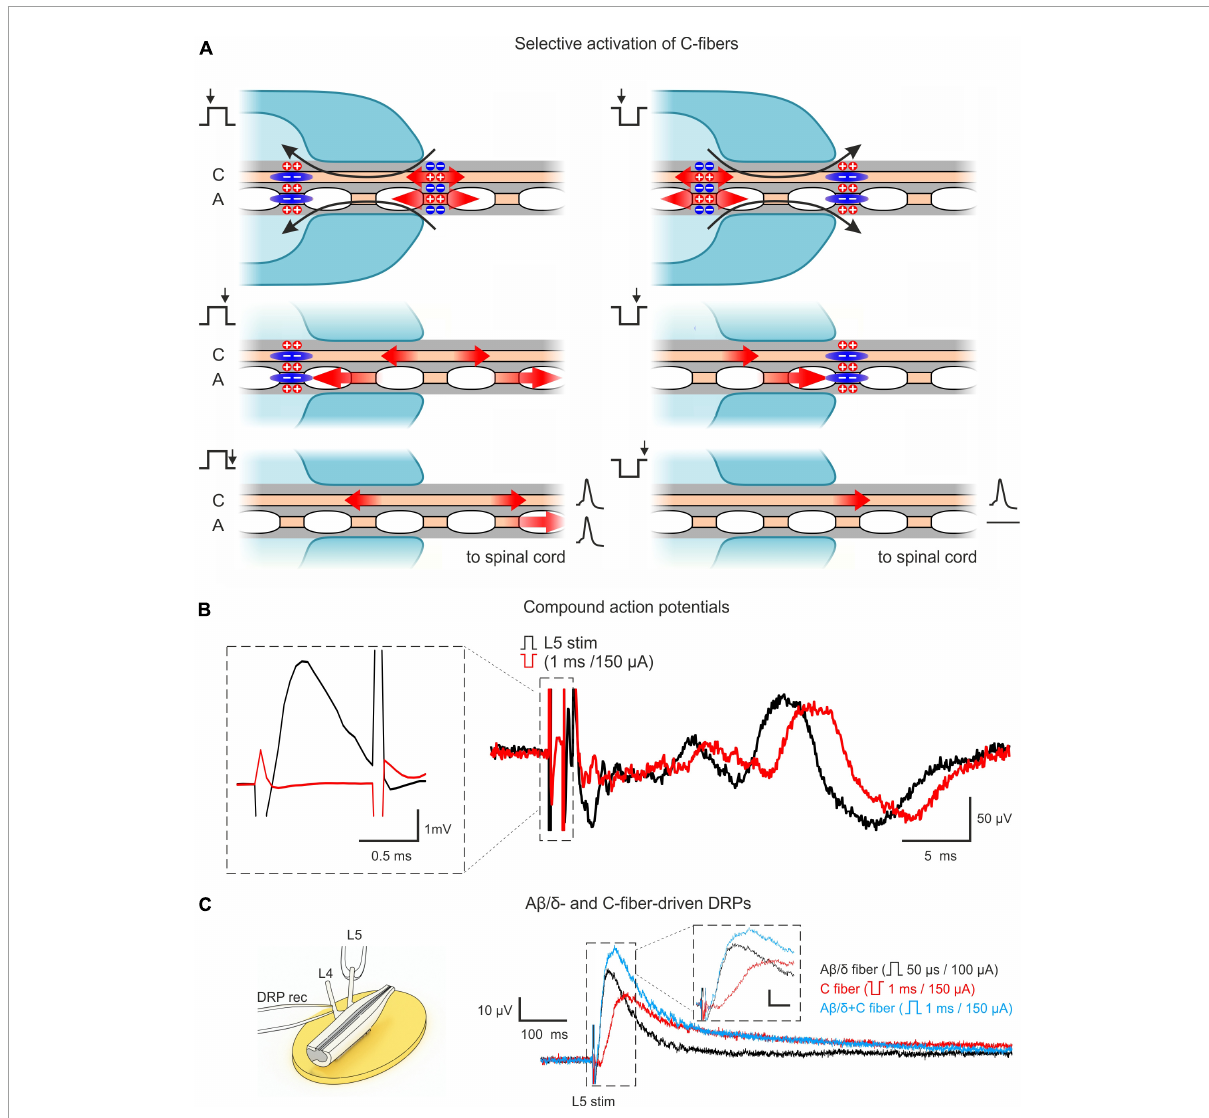
FIGURE1 Approach for studying AD-PI in the spinal cord. (A) Technique for selective C-fiber activation by the inverted 1 ms pulse stimulation. Red arrows represent the spread of excitation. Blue zones represent regions of hyperpolarization-induced conduction block (anodal block). Given pipette lip geometry and difference in conduction velocities, A β / δ -fiber spikes produced by the negative stimuli at the internal end of the pipette lips are blocked at the external end, while C-fiber spikes can propagate to the spinal cord. A detailed description is given in the text. (B) C-fiber components of compound action potentials (CAPs) elicited by stimuli of normal (+150 µ A × 1 ms, black) and inverted polarity (–150 µ A × 1 ms, red). Given the difference in spike initiation sites, C-fiber latency is increased by 2–3 ms for inverted stimuli. The inset shows that a 1 ms stimulus of inverted polarity suppresses the A-fiber-mediated CAP component. (C) Dorsal root potential (DRP) recordings from hemisected spinal cord showing A β / δ - and C-fiber-driven DRPs. Left: Experimental design. Right: L4 DRPs (averages of 10 traces; recordings from the same preparation) induced by L5 root stimulation activating only A β / δ -fibers (+100 µ A × 50 µ s, black), only C-fibers (–150 µ A × 1 ms, red), and A β / δ + C-fibers (+150 µ A × 1 ms, blue). Inset scale bar: (10 µ V, 20 ms). Note that C-fiber-induced DRP peaks at approximately 100 ms.